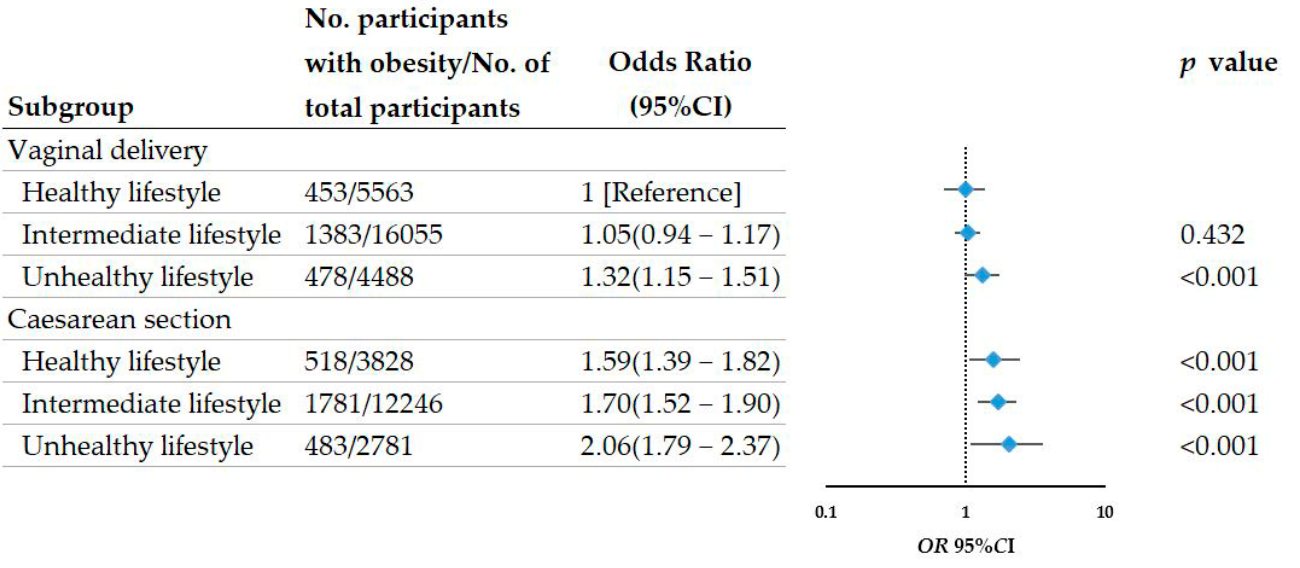
Figure 1. Risk of obesity according to delivery mode and lifestyle in children and adolescents aged 6–18 years.